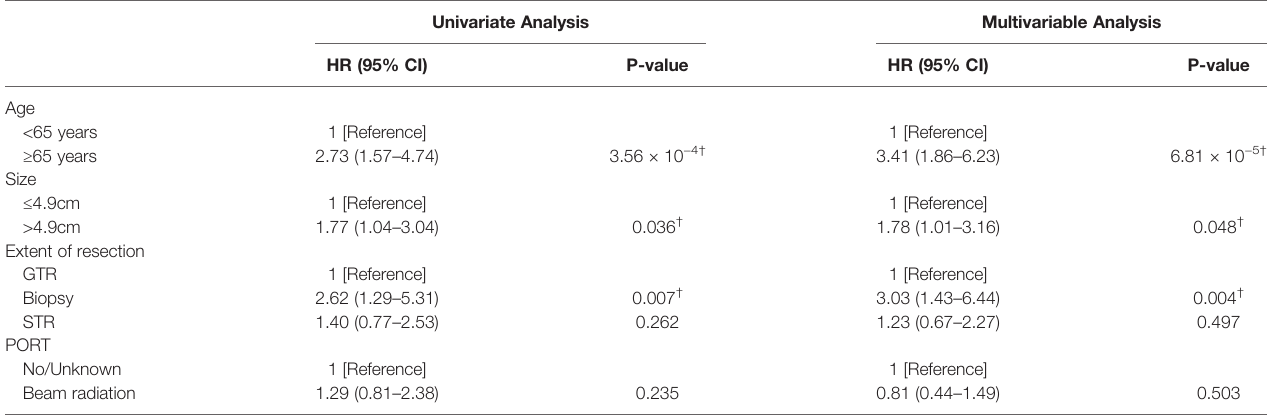
TABLE 2 | Results of univariate and multivariable Cox proportional regression analysis of age group, tumor size, EOR, and PORT in the entire study population. Univariate Analysis